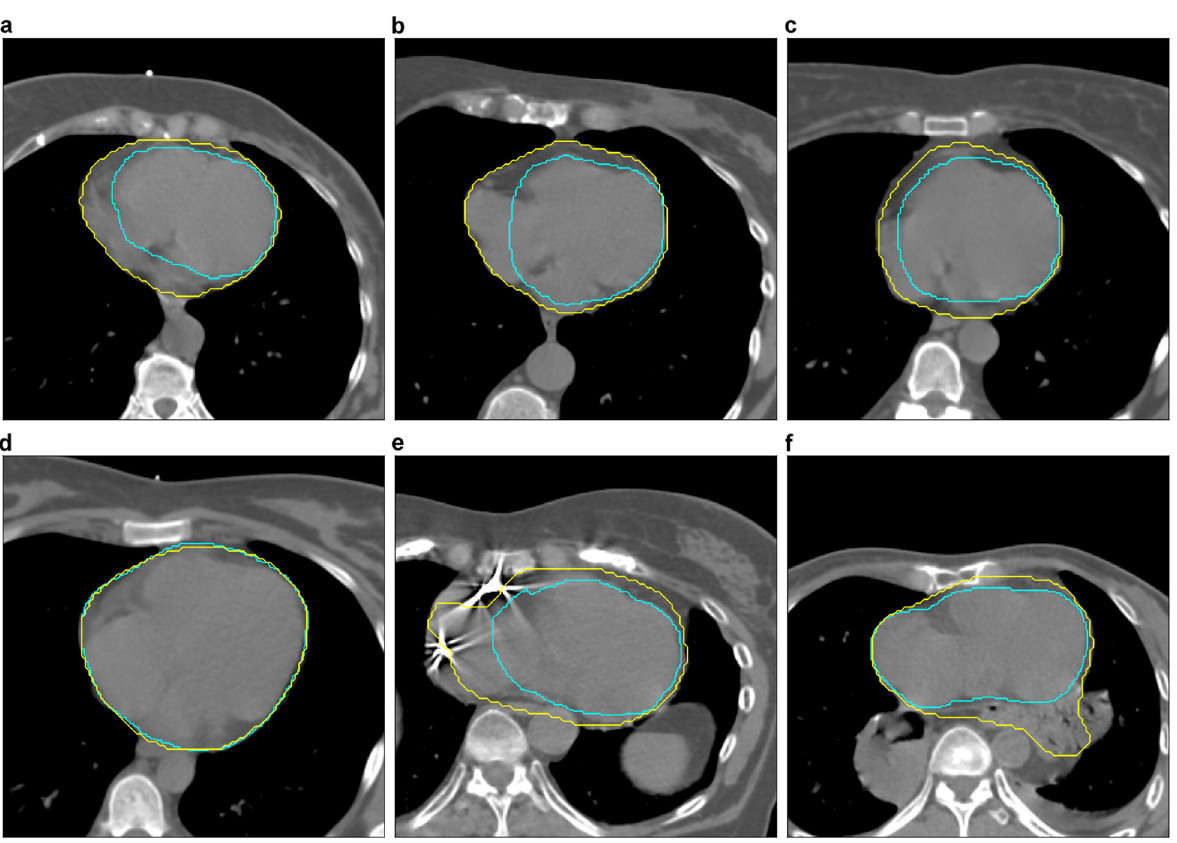
Fig. 4 Segmentation accuracy of AI (Yellow) and manual (Cyan) segmentations. All manual segmentations were created by medical experts and approved by a radiation oncologist for treatment. Quality ratings (poor, fair, excellent) were made by a board-certi fi ed radiologist